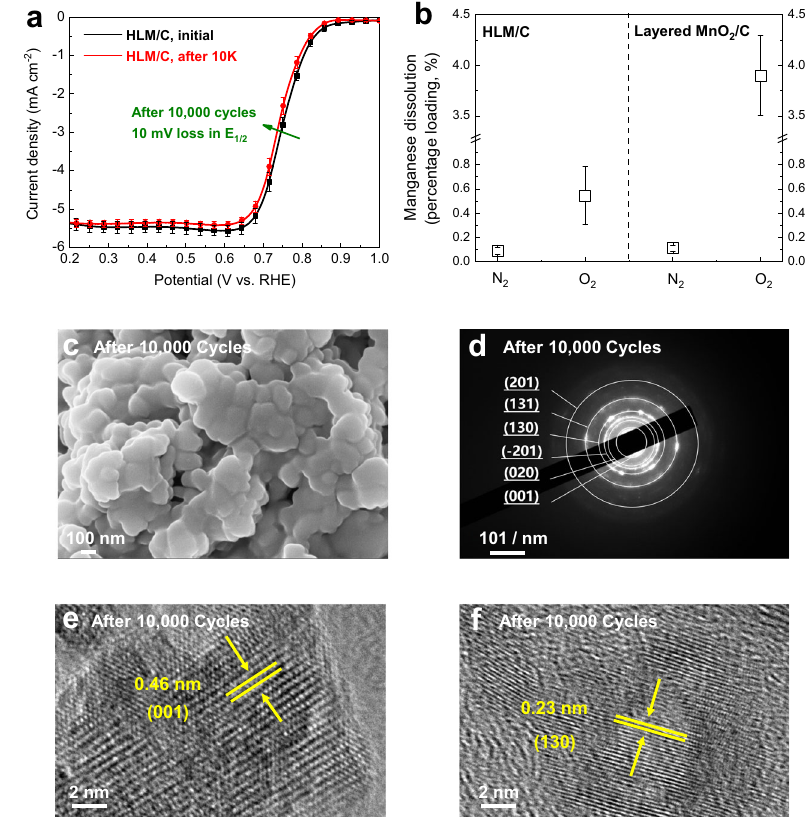
Fig. 4 Stability characterization and ion dissolution behaviors. a Stability studied by using potential cycling of HLM/C. b Total amount of Mn dissolution studied by ICP for HLM/C and layered MnO 2 /C. Error bars represent the standard deviation of at least three independent measurements. c SEM image of HLM after 10,000 cycles. d SAED of HLM after 10,000 cycles. e , f Corresponding HR-TEM images with selected regions of HLM after 10,000